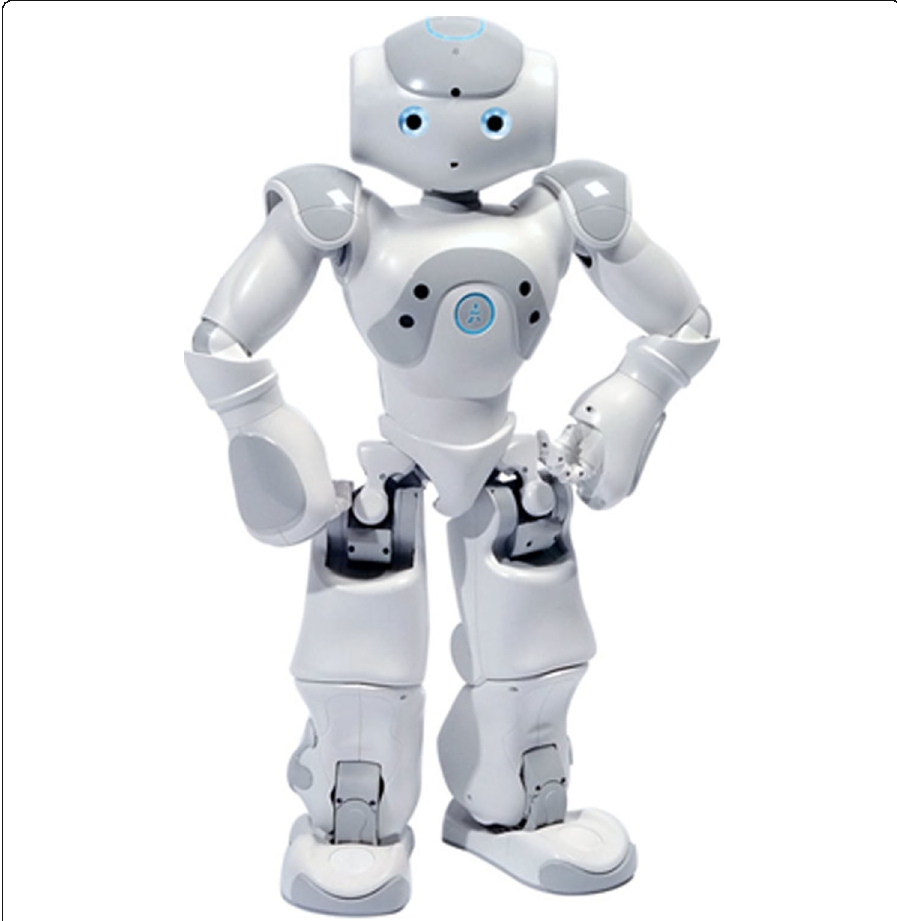
Fig. 6 NAO robot (Robocup version)